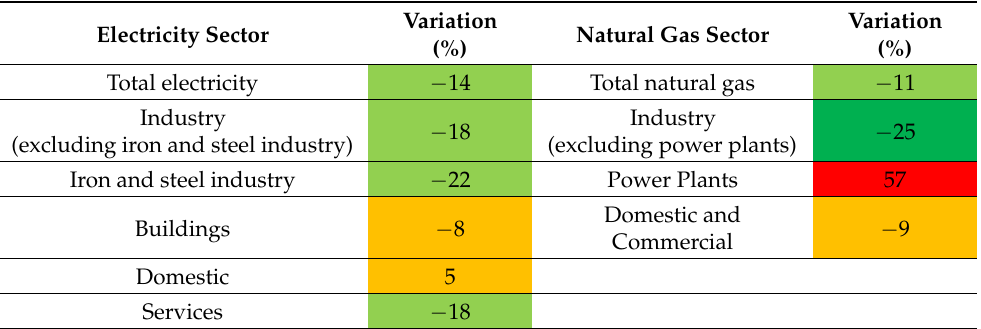
Table 5. Variation of the energy consumption (electricity and natural gas) by main sector in 2020 rela- tive to 2019, for the March–June average. Large reduction (up to − 25.0%), reduction (from − 24.9% to − 10.0%), small reduction or increment (from − 9.9% to 10.0%), increment (above 10.1%) . Variation Variation Natural Gas Sector Electricity Sector (%) (%) Total electricity − 14 Total natural gas − 11 Industry −